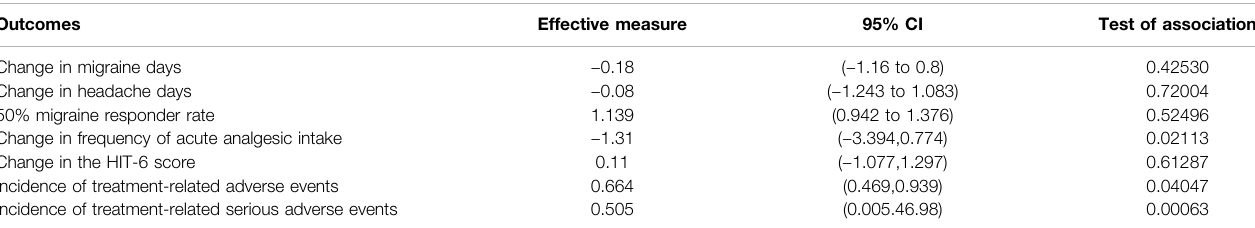
TABLE 2 | Indirect treatment comparison analysisof ef fi cacy and safety outcomes ofCGRP monoclonal antibody vs. botulinum toxinfor the preventive treatment of chronic migraine.